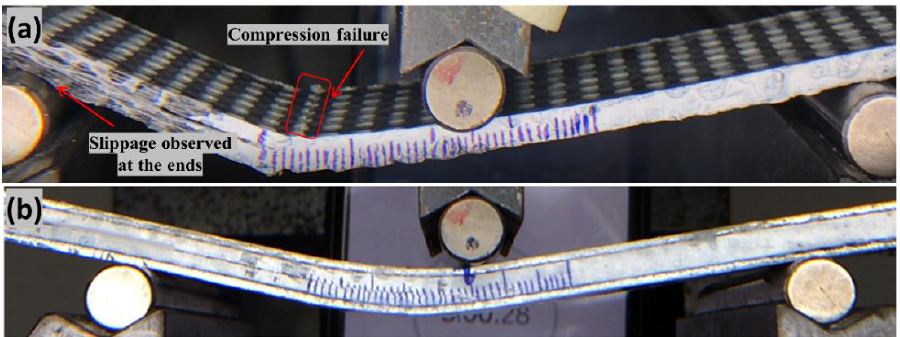
Figure 6 . ( a ) Hybrid composite premature compression failure under mode II testing without dou- bler ( b ) Hybrid composite specimen under Mode II with doubler . ( b ) Hybrid composite specimen under Mode II with